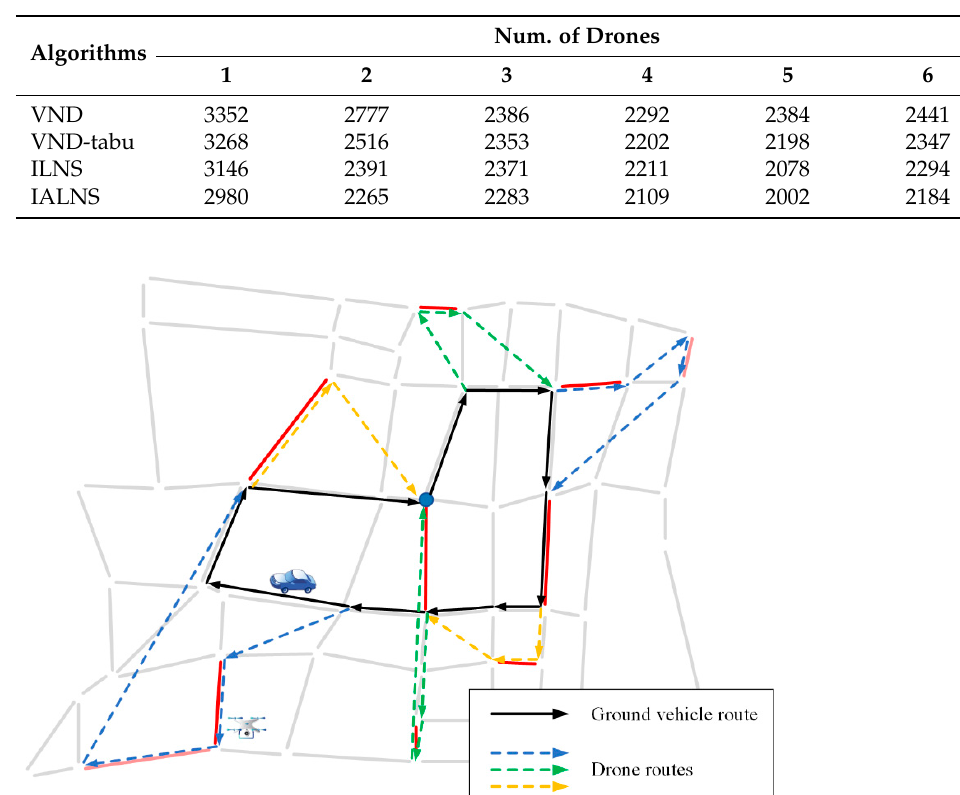
Figure 16. Simplified road network in a certain area of Changsha City. The parameter settings are the same as in Section 5.1. The patrol time (second) with different numbers of drones is presented in Table 9, and the route planning of the vehicle and the drones, obtained by IALNS, is shown in Figure 17. Table 9. Patrol time (s) with different numbers of drones.